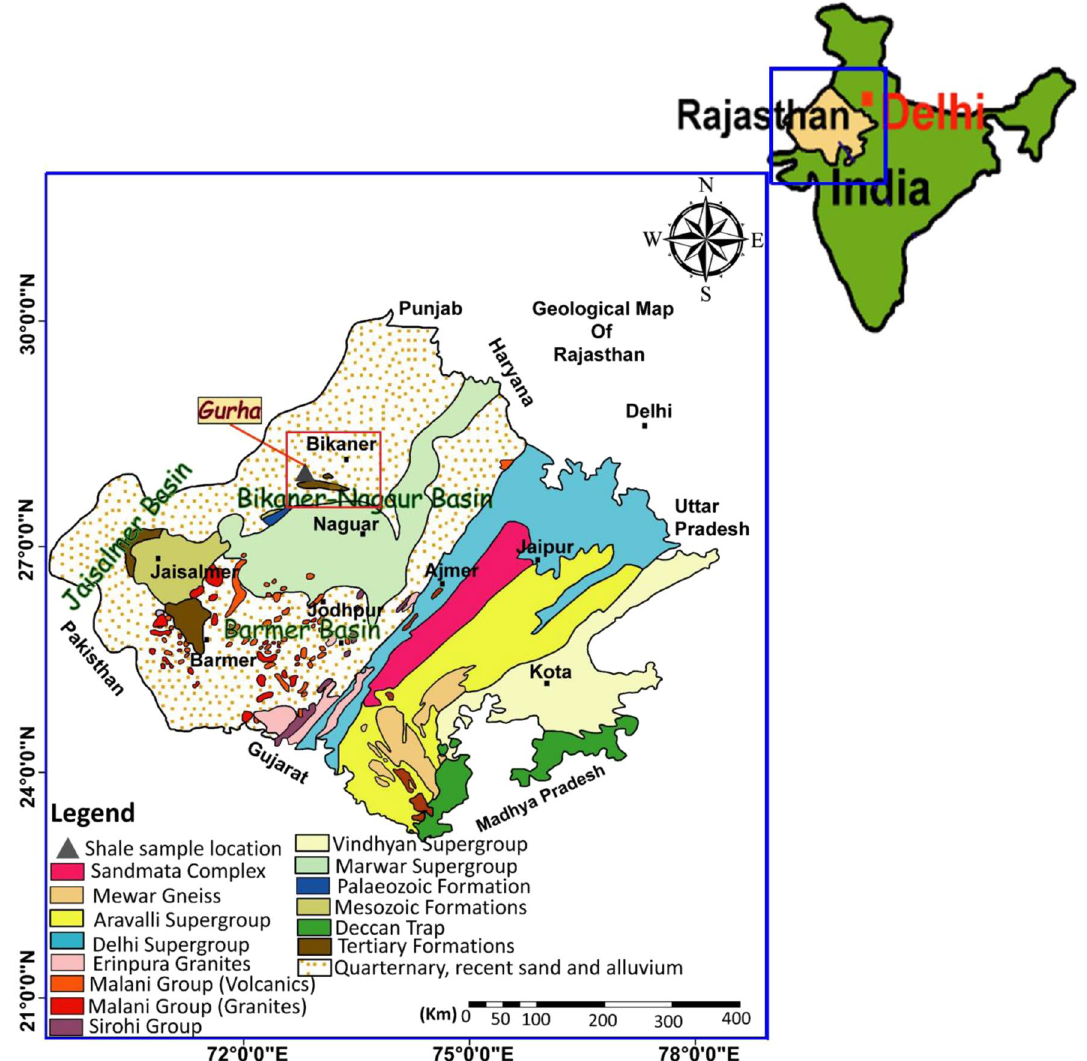
Figure 1. Geological map of Rajasthan showing the Gurha mine location in the Bikaner-Nagaur Basin, northwestern India. Arc Map GIS software 10.2.2 is used to create this figure,